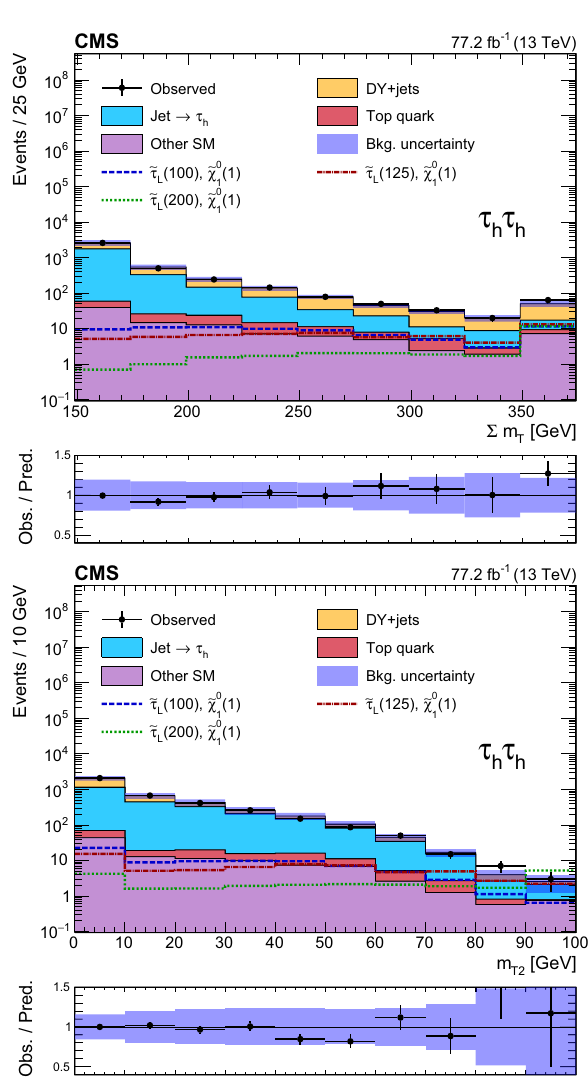
Fig. 2 Distributions in Σ m T (upper) and m T2 (lower) for events in the combined 2016 and 2017 data sets passing the baseline selection τ in the τ final state, along with the corresponding prediction for the h h SM background and three benchmark models for (cid:2) τ L pair production ) = 1GeV. The numbers with m ( (cid:2) τ L ) = 100, 125, and 200GeV, m ( (cid:2) χ 0 1 within parentheses in the legend correspond to the masses of the (cid:2) τ L and (cid:2) χ 0 in GeV. The last bin includes overflow events in each case. 1 The shaded uncertainty bands represent the combined statistical and systematic uncertainties in the background or muon momentum vector and (cid:4) p miss , to be between 20 and T 60 GeV or above 120 GeV. A significant background from DY+jets events is reduced by requiring the invariant mass of , m (cid:2) τ to be above 50 the electron or muon and the τ h h